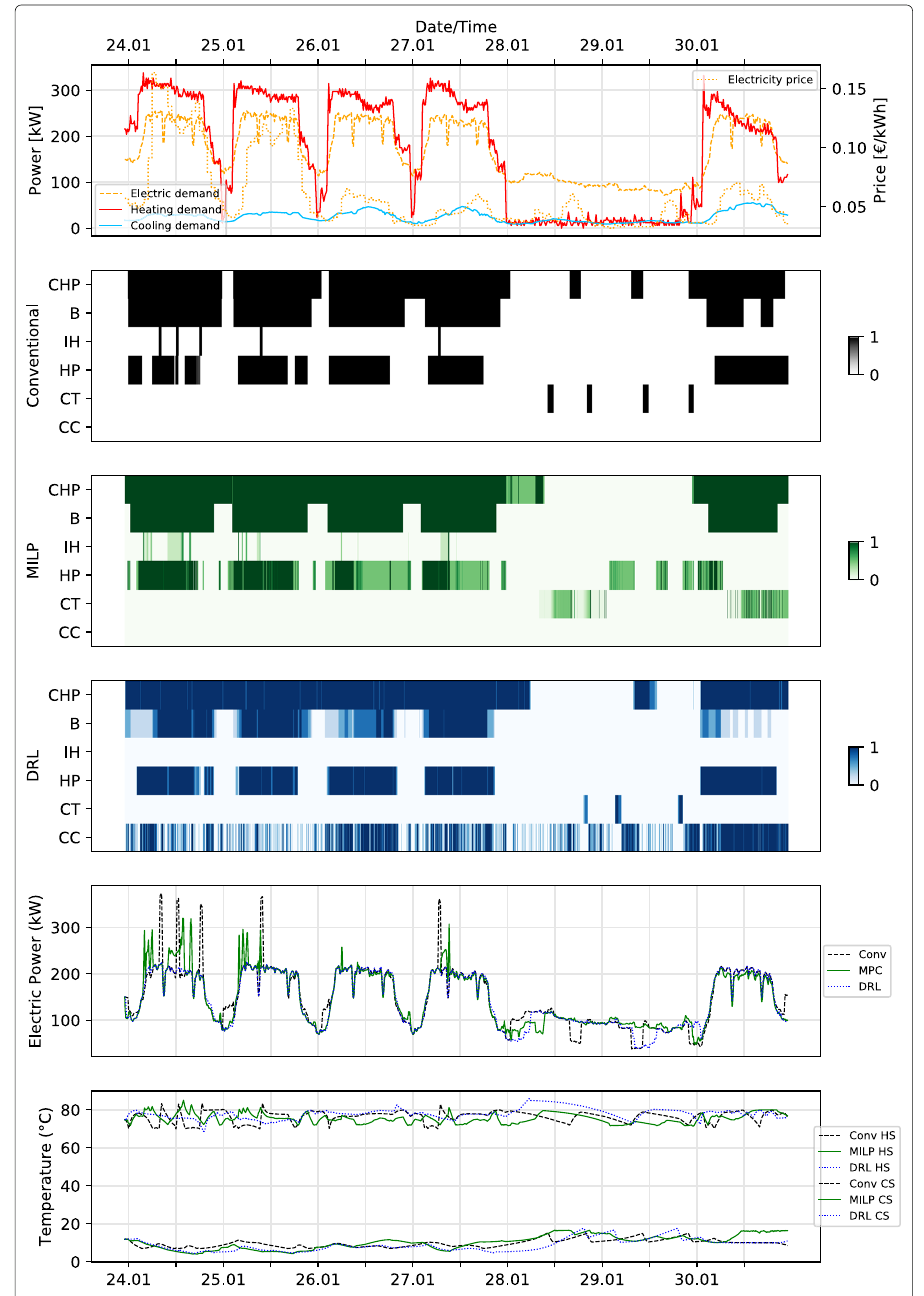
Fig. 6 Exemplary test run of system B with an episode duration of seven days and a sampling time of three minutes. Subplot 1 shows input parameters as electricity and heating demand of the production system as well es electricity prices. Subplots 2-4 show the resulting actions of the control algorithms and subplots 5 and 6 contain the electric power demand to the grid and the temperature of the HS and CS